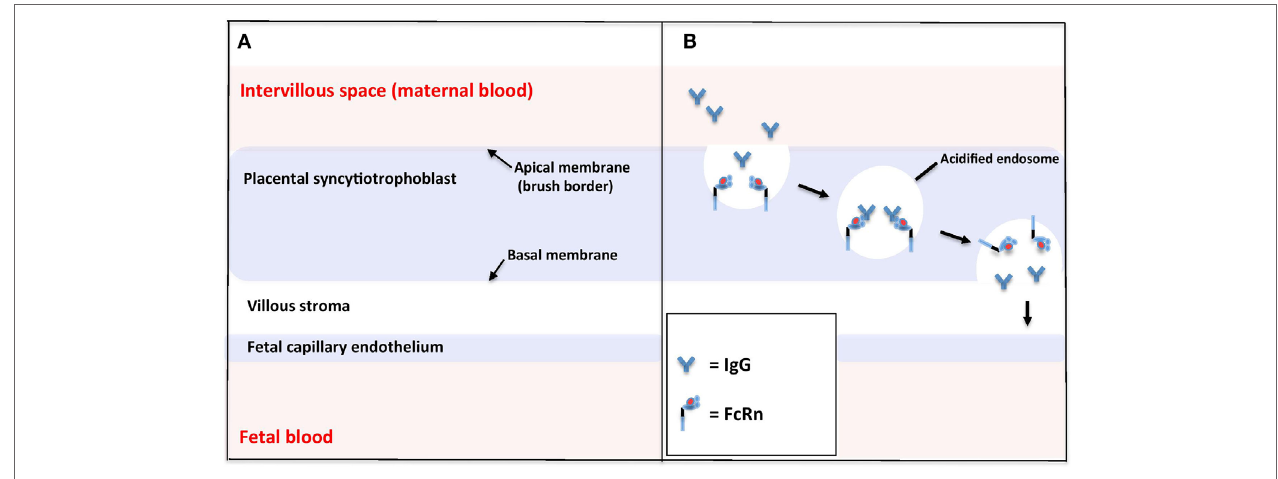
FiGURe 2 | Schematic of the microstructure of the human placental barrier at term (A) and the neonatal Fc receptor (FcRn)-mediated endocytosis of immunoglobulin G (IgG) across the placental syncytiotrophoblast (B)